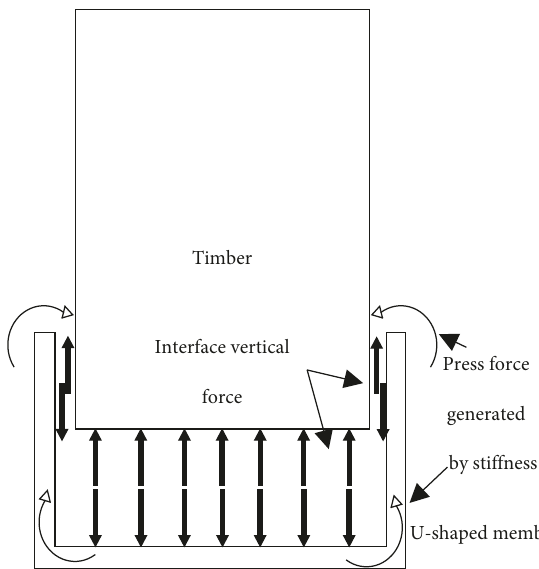
Figure 3: The mechanics model in cross section of U-section combined with timber